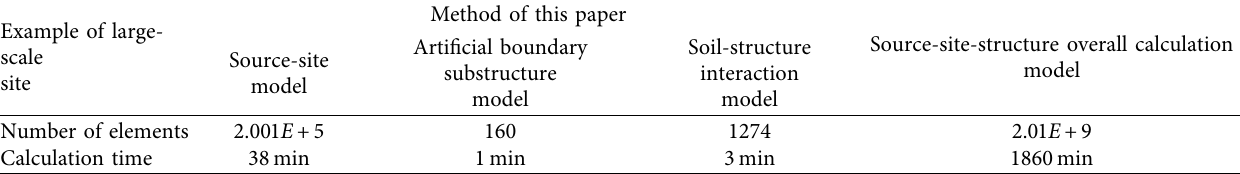
Table 2: Comparison of the calculation efficiencies between two methods.